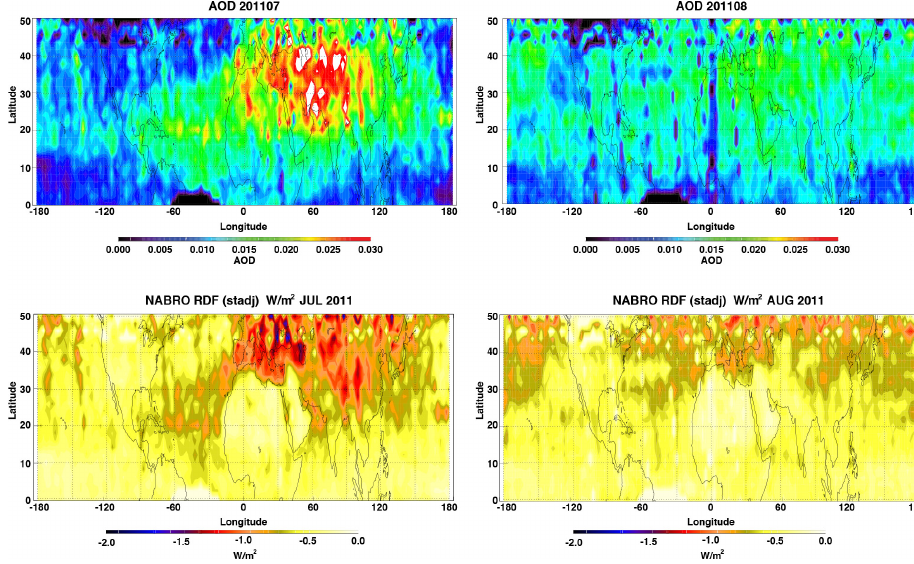
Figure 8. 532nm AOD and TOA estimates of radiative forcing, based on monthly accumulations of CALIPSO aerosol data between 14 and 40km altitudes for July and August, 2011. Stratospheric temperature adjustment is included in the radiative forcing